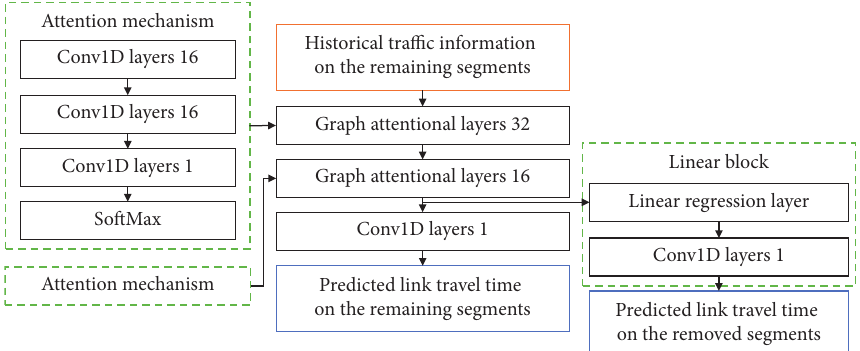
Figure 4: Details of the model